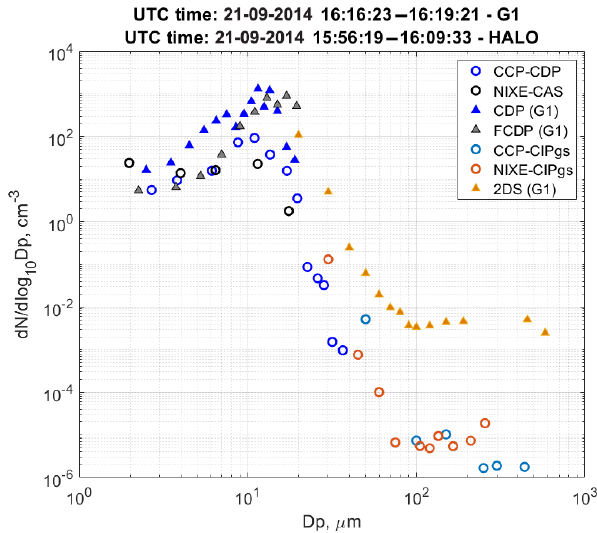
Figure 15. The cloud droplet size distribution from the cloud probes on the G1 and